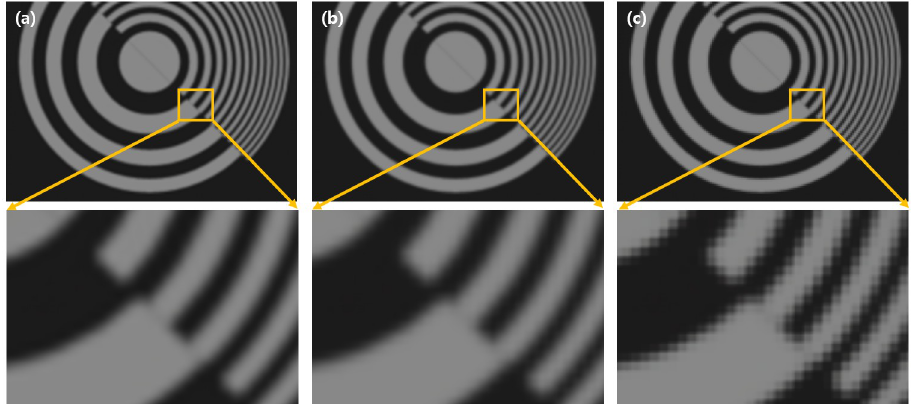
Figure 9. Simulation results with ( a ) bicubic, ( b ) bilinear, and ( c ) nearest,